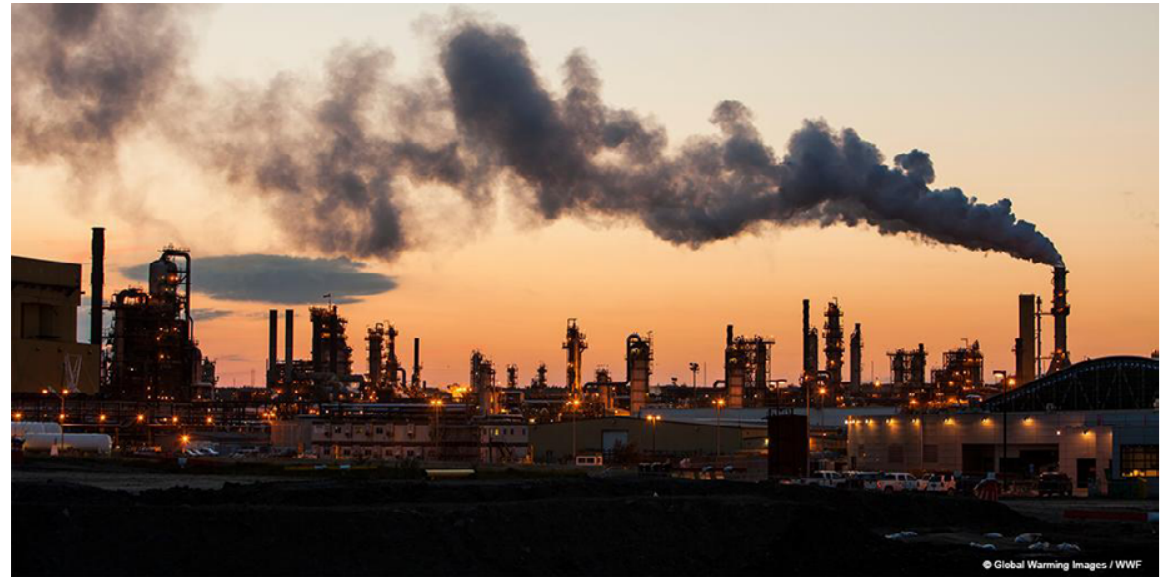
World Wildlife Fund, “Air Pollution Comes from 5 Main Human Sources,” Twitter , June 5, 2019,